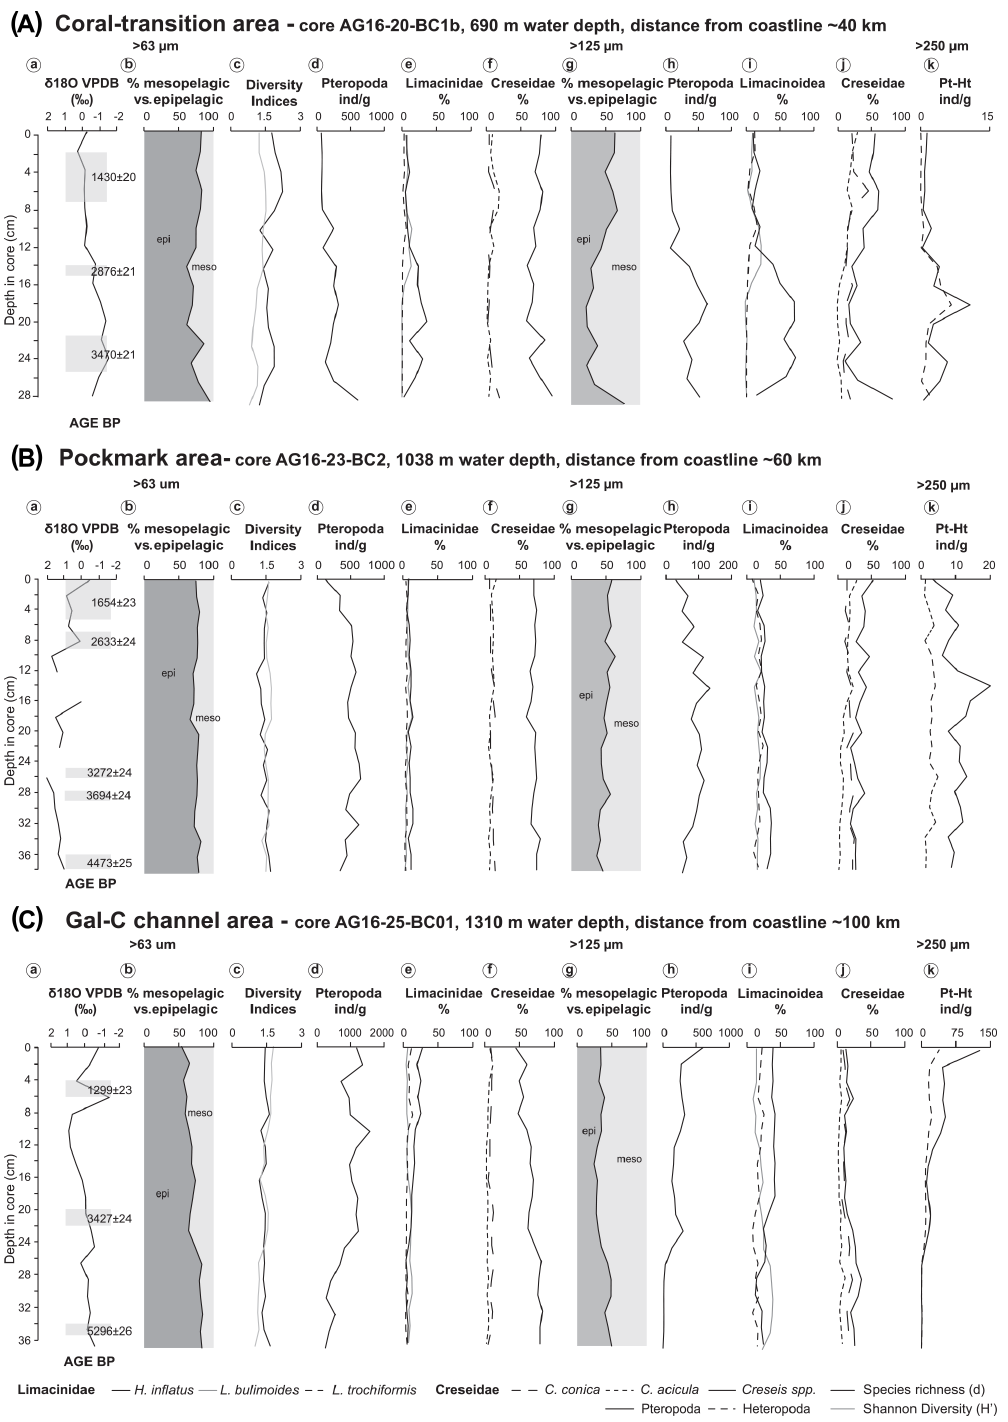
Figure 5. Stable isotopes, dating, and quantitative analyses of pteropods (b–f for the > 63µm and g–j for the > 125µm size fraction) for the following cores: (A) coral-transition area (core AG16-20-BC1b), (B) pockmark area (core AG16-23-BC2), and (C) Gal-C channel area (core AG16-25-BC1a). (a) δ 18 O values and radiocarbon dating ( 14 C) shown for each core. (b, g) % epipelagic (dark grey) vs. % mesopelagic (light grey) species; (c) species richness (solid black line) and Shannon diversity ( H (cid:48) , solid light grey line), calculated on the total fraction > 63µm. (d, h) Pteropod abundance per gram of sediment; (e, i) Limacinioidea: percentage of H. inflatus (solid line), L. bulimoides (grey solid line), and L. trochiformis (dashed line). (f, j) Creseidae: percentage of C. conica (widely spaced dashed line), C. acicula (closely spaced line), and unidentified protoconchs of Creseis spp. (solid line). (k) Numerical abundance per gram of pteropods vs. heteropods in the > 250µm